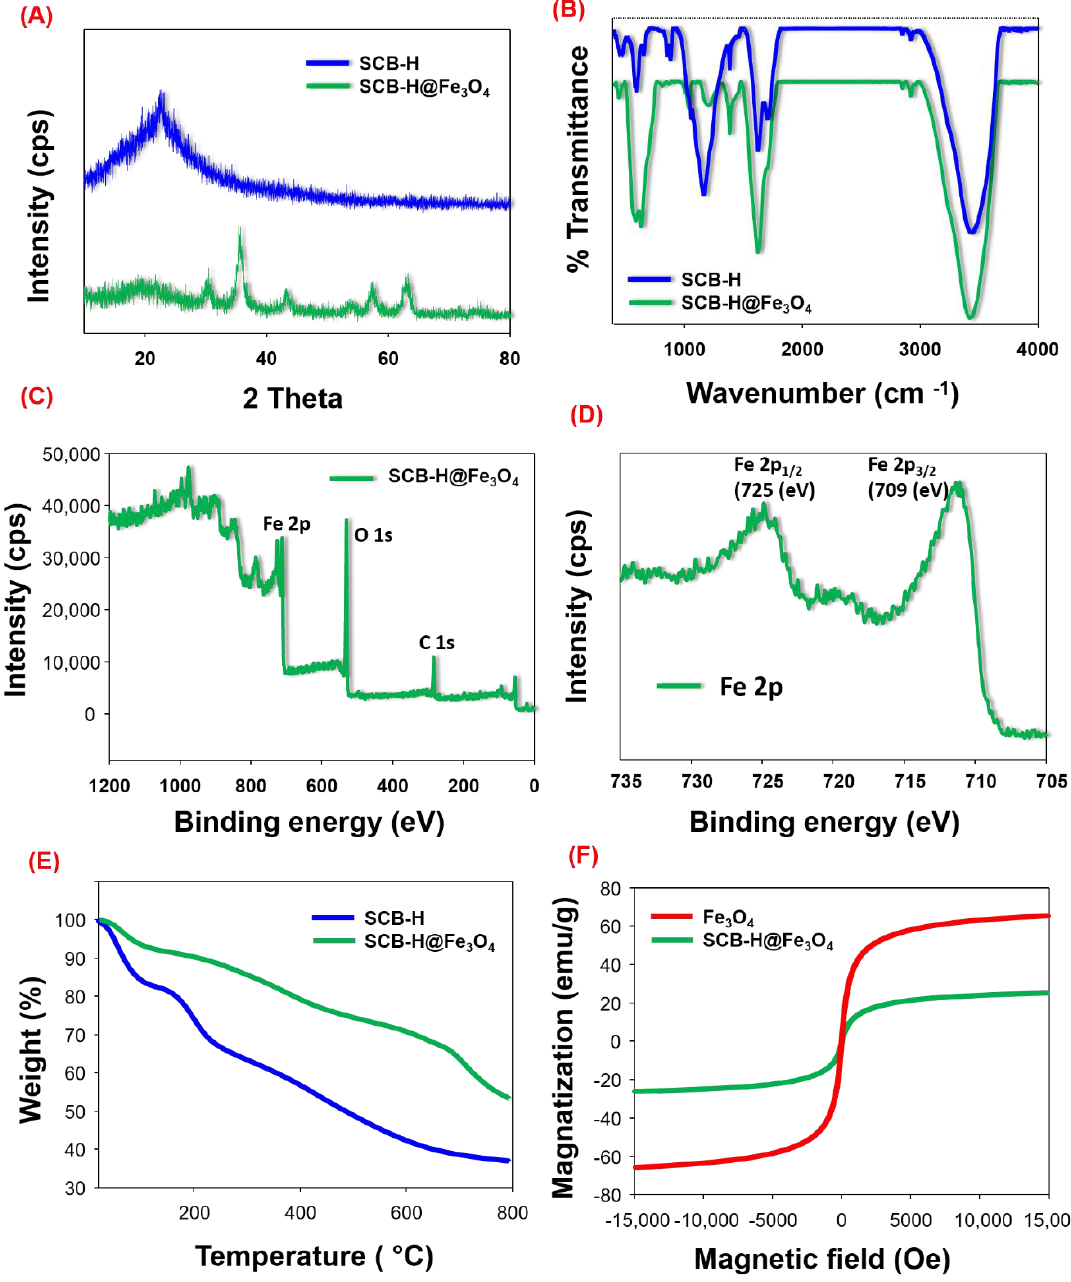
Figure 2. XRD ( A ) and FT-IR ( B ) analysis of SCB-H and SCB-H@Fe 3 O 4 , ( C ) XPS analysis of SCB-H@Fe 3 O 4 , ( D ) high-resolution spectrum of Fe 2p , TGA analysis of SCB-H and SCB-H@Fe 3 O 4 ( E ), and VSM analysis of Fe 3 O 4 and SCB-H@Fe 3 O 4 ( F ).